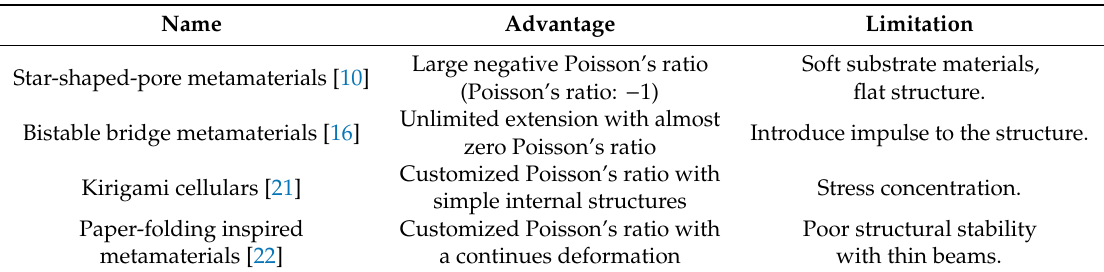
Table 1. Various types of Poisson’s ratio related metamaterials and their limitations.